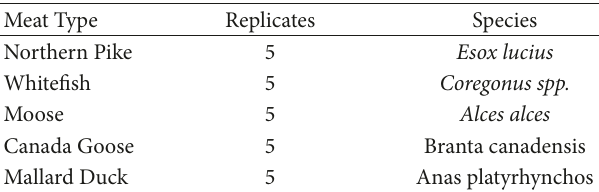
Table 2: Wild Meat Collected for AA